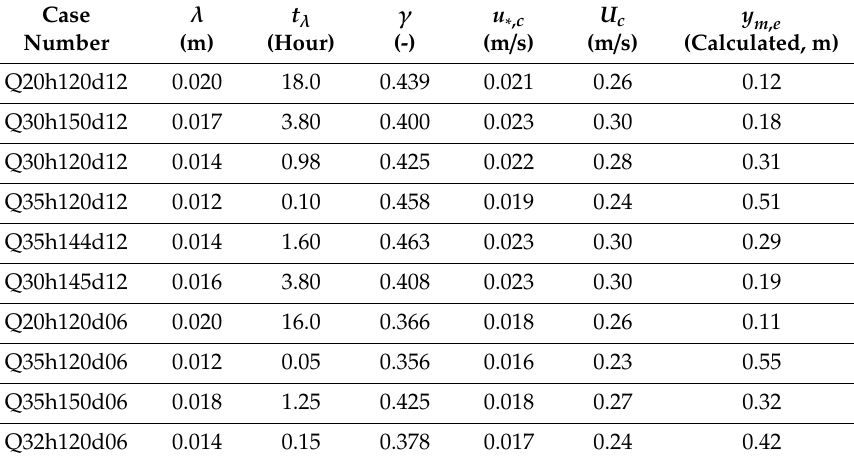
Table 3. Measured quantities of scour